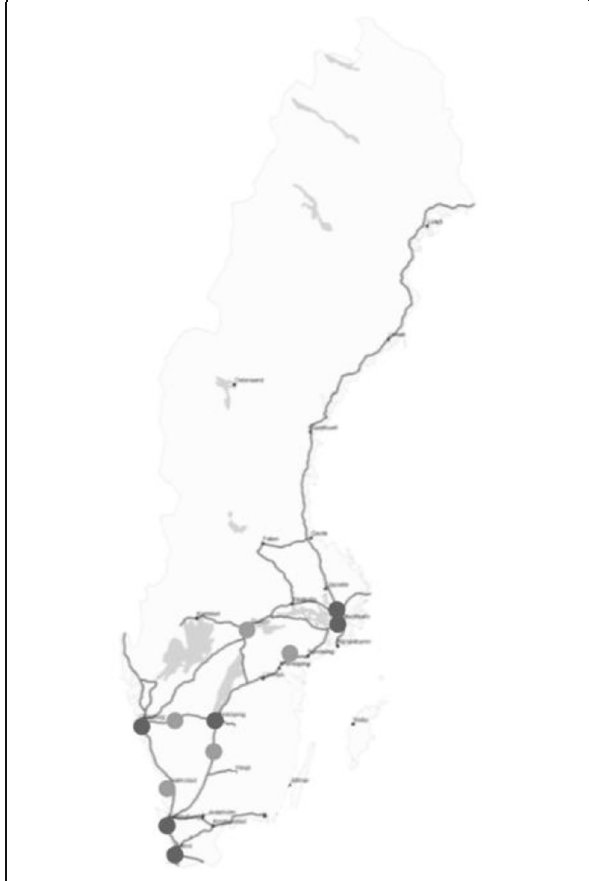
Fig. 3 Illustration of suggested designated roads to permit longer vehicles of 34.5 m